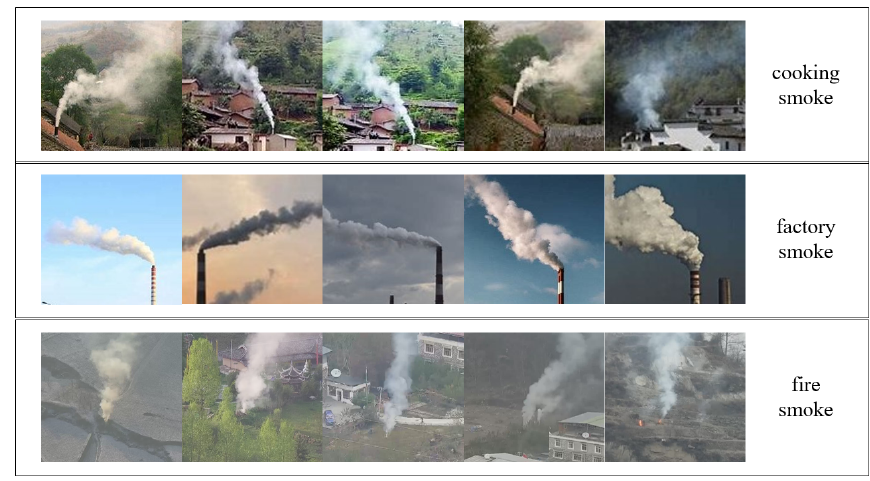
Figure 3. Partial data from the dataset used by the fine-grained smoke identification task.